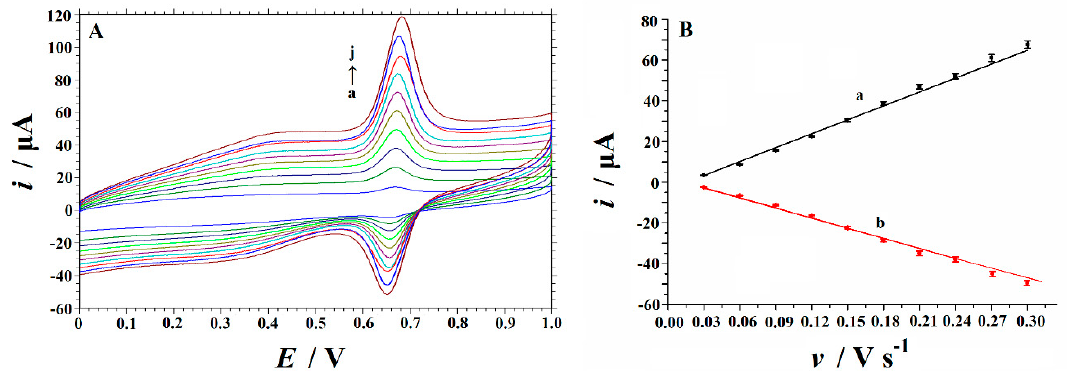
Figure 6. ( A ) Cyclic voltammograms of 10 µM rutin in 0.1 mol L − 1 HCl solution on NH 2 -Fe 3 O 4 NPs-ErGO/GCE at various scan rates (Form a to j: 0.03, 0.06, 0.09, 0.12, 0.15, 0.18, 0.21, 0.24, 0.27, 0.3 V s − 1 , respectively); ( B ) Plot of oxidation peak currents ( a ) and reduction peak currents ( b ) versus scan rates.